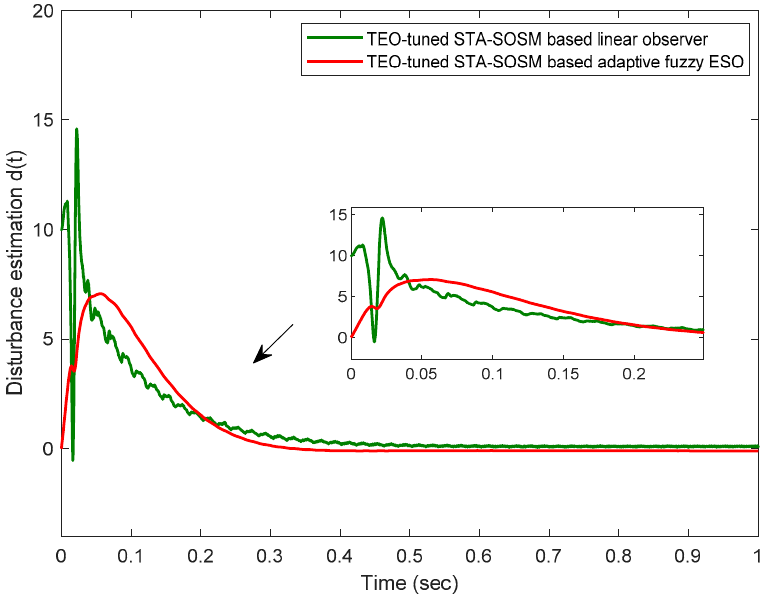
Figure 11. Total disturbance estimations’ comparison of the reported observers.